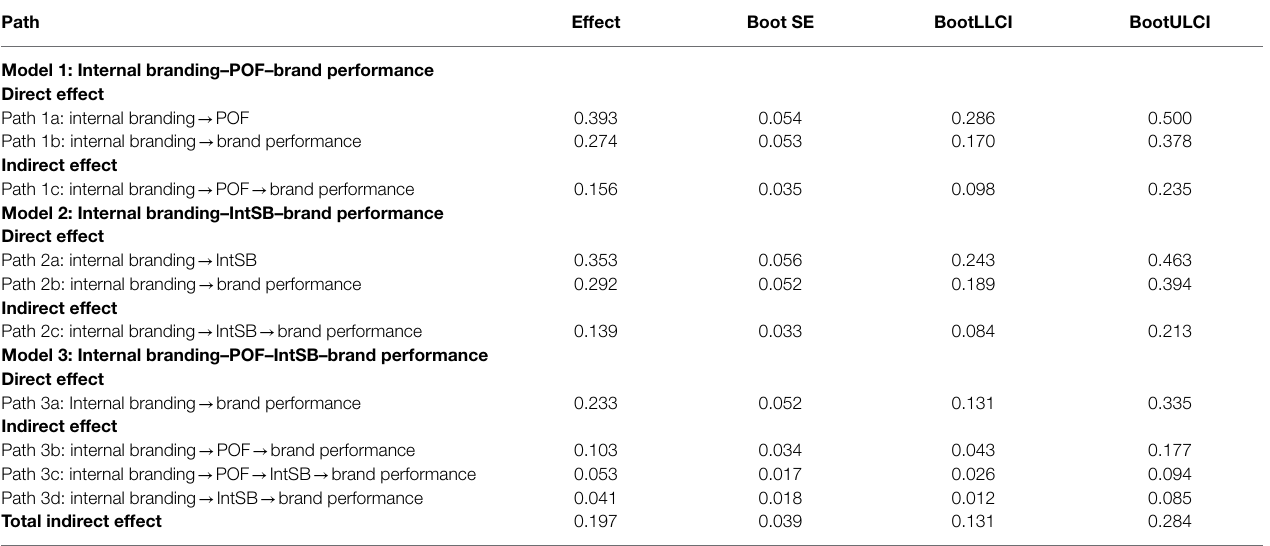
TABLE 4 | Direct, indirect, and total indirect effects for the model. Path Effect